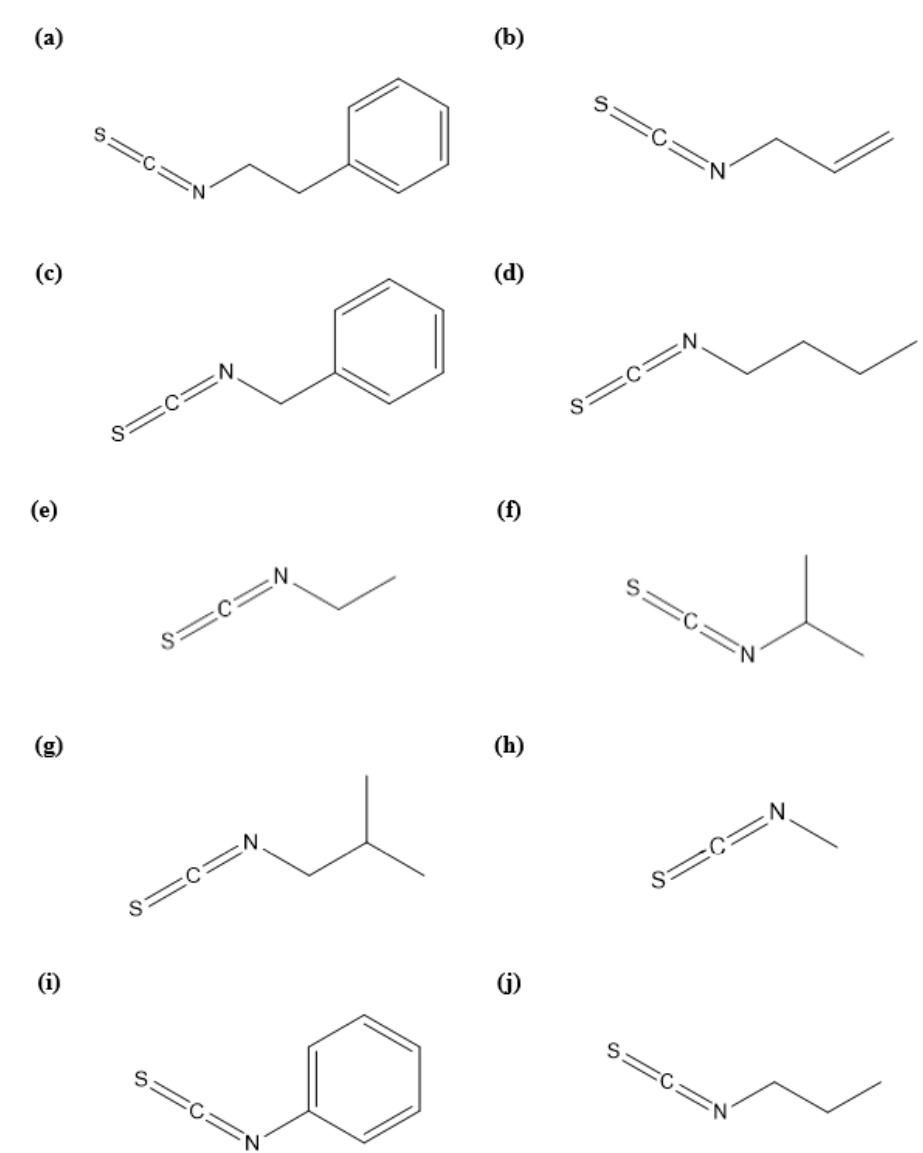
Figure 1. Chemical structures of phenethyl isothiocyanate ( a ) isolated from Armoracia rusticana root oil and its derivatives, allyl isothiocyanate ( b ), benzyl isothiocyanate ( c ), butyl isothiocyanate ( d ), ethyl isothiocyanate ( e ), isopropyl isothiocyanate ( f ), isobutyl isothiocyanate ( g ), methyl isothiocyanate ( h ), phenyl isothiocyanate ( i ), and propyl isothiocyanate ( j ).